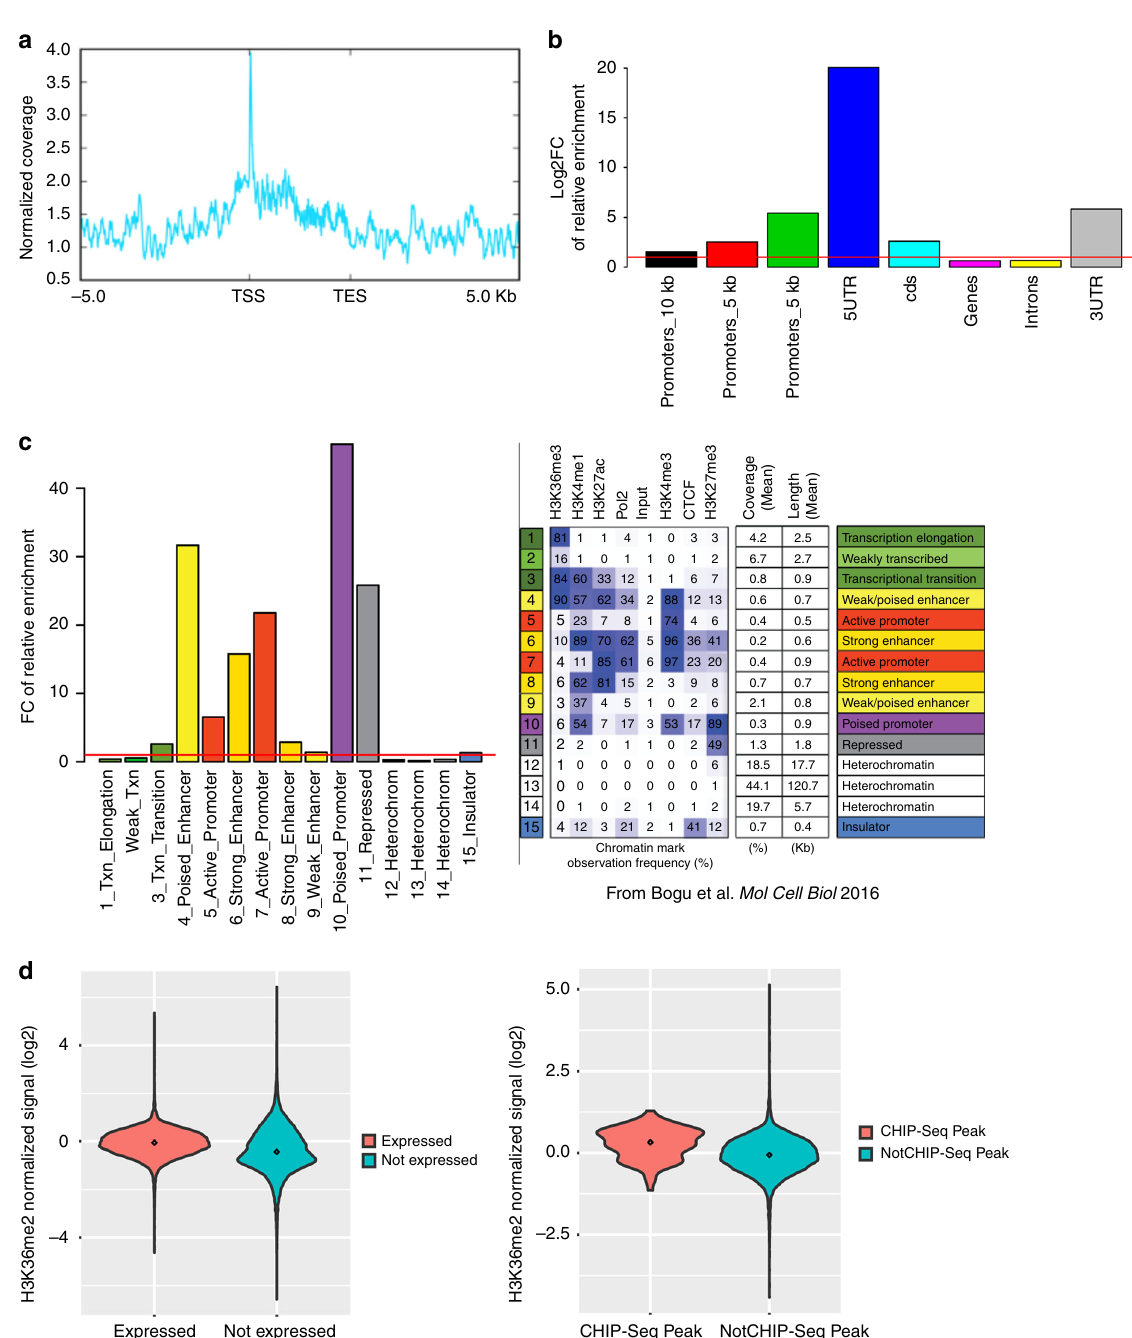
Fig. 5 Distribution of Ash1L peaks and overlapping between Ash1L and Polycomb targets. a Ash1L ChIP-seq signal distribution over the scaled gene bodies (3 kb) of its targets showing enrichment around the TSS. One representative replicate of the three is shown. b Relative enrichment (log 2 FC) of Ash1l ChIP- seq peaks in classically de fi ned genomic regions (promoters, 5 ′ -UTR, CDS, genes, introns, and 3 ′ -UTR). c Relative enrichment (FC) of Ash1L ChIP-seq peaks in genome-wide chromatin segments as found in Bogu et al. 63 (right panel reproduced with permission from American Society for Microbiology) in a union of mouse tissues using chromHMM tool. d Violin plots of normalized H3K36me2 signal over gene bodies of either expressed/unexpressed in myoblasts (left panel) or Ash1L peaks/not Ash1L peaks genes (right panel). Signal has been normalized against H3 ChIP control sample and three replicates averaged. Mann – Whitney p value was used for